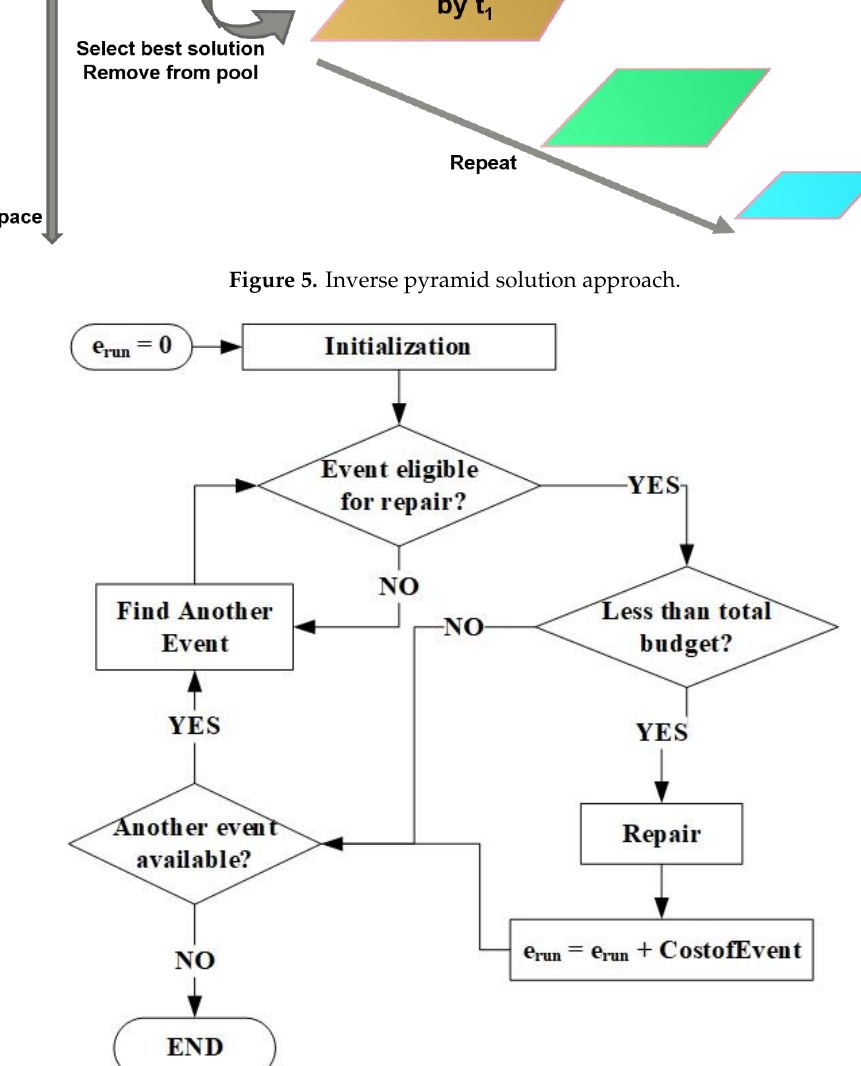
Figure 6. Updated budget equation methodology.